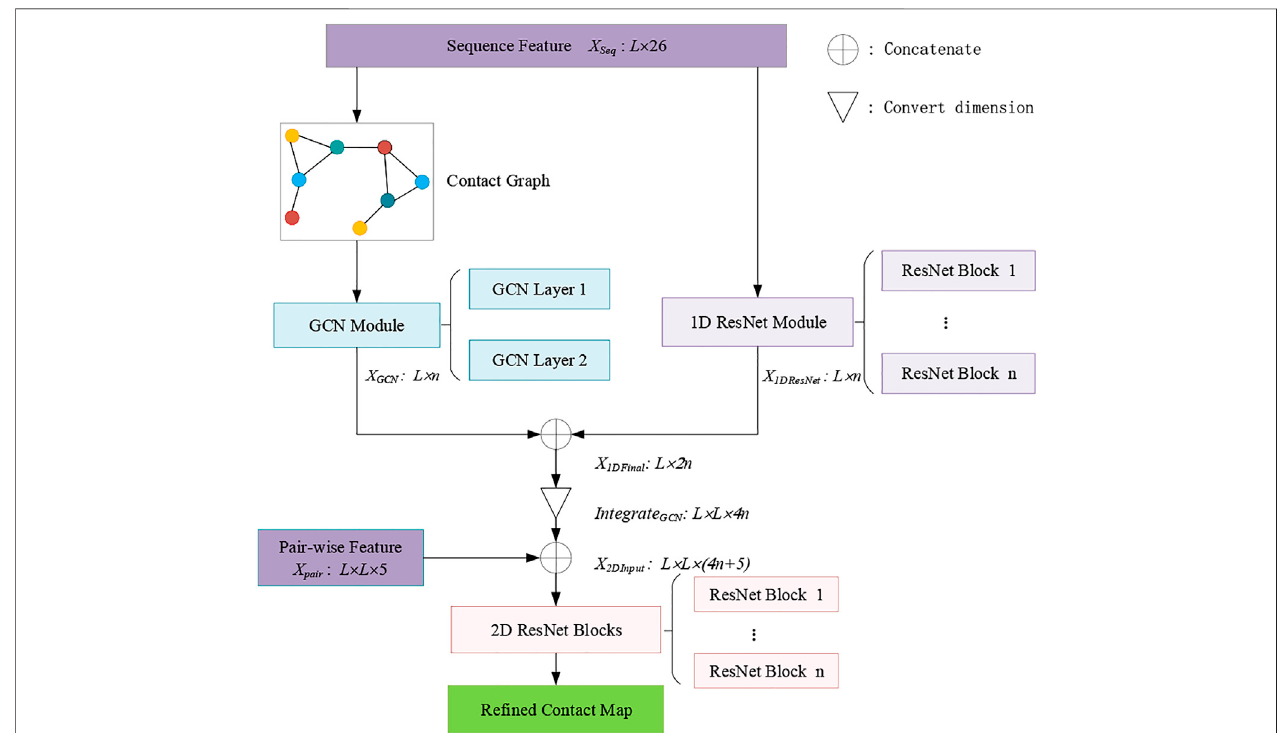
FIGURE 1 | Framework of the